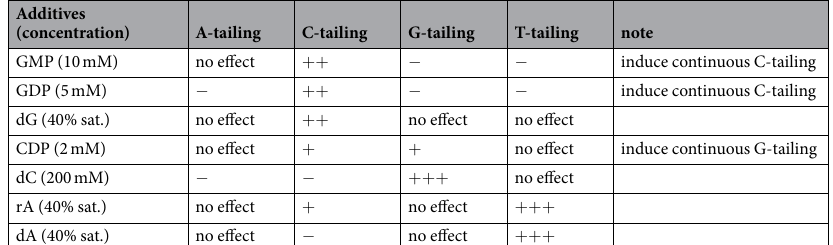
Additives (concentration) A-tailing C-tailing G-tailing T-tailing